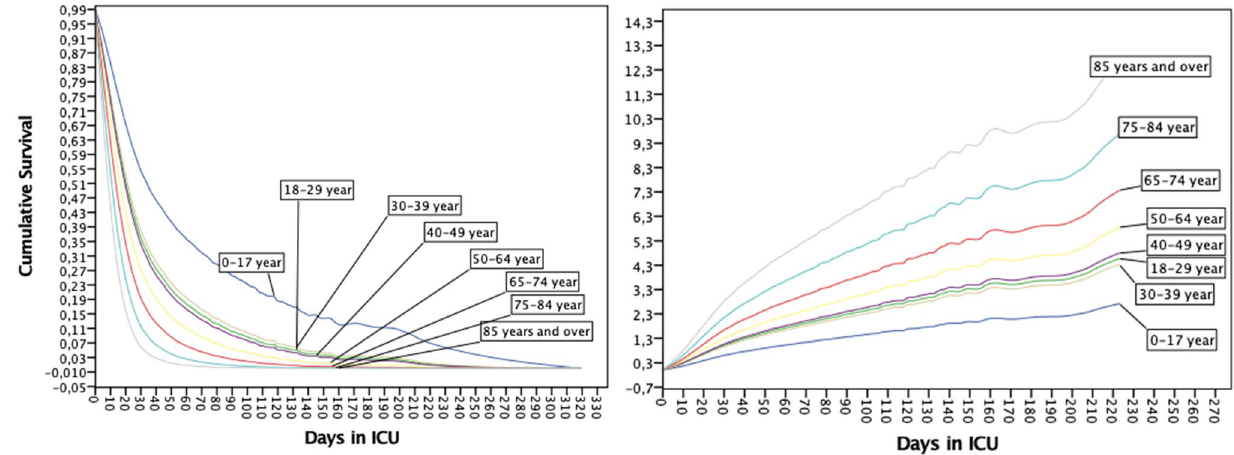
Figure 3. Cumulative survival (left panel) and cumulative hazard (right panel)” during ICU